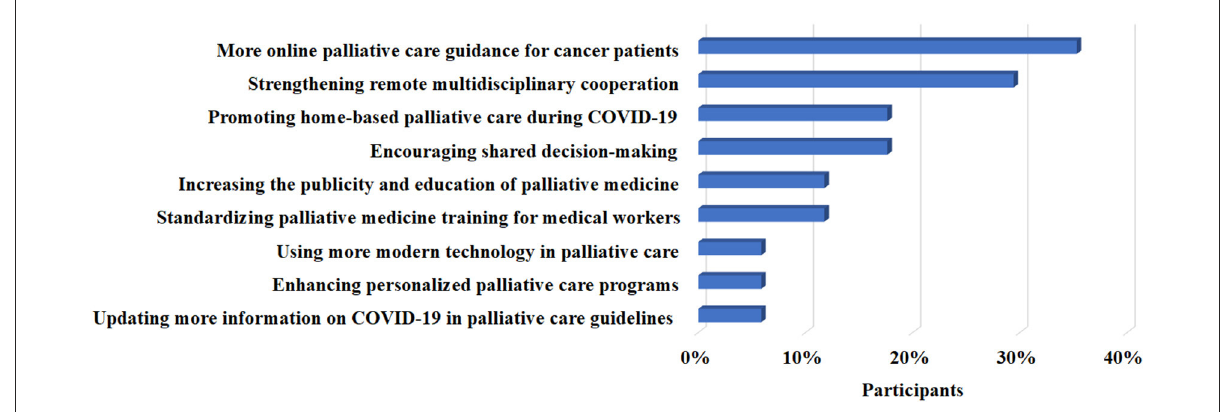
FIGURE2 Personal suggestions on developing palliative care under the COVID-19